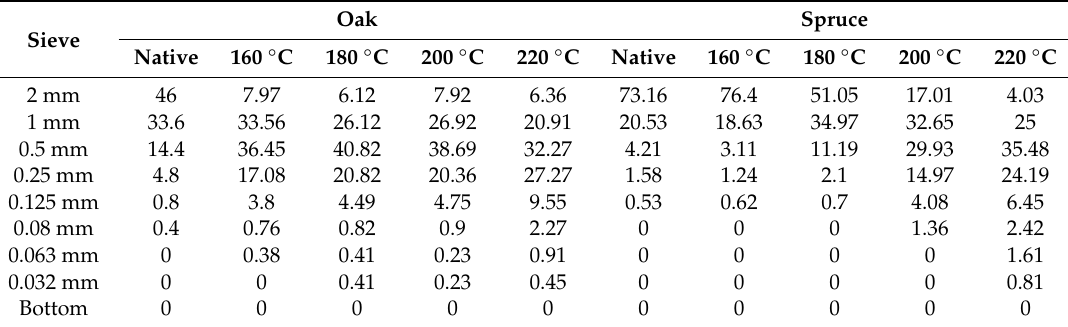
Table 3. Percentage of particles on individual mesh sieves in the case of both oak wood and spruce wood with feed rate v f = 15 m · min − 1